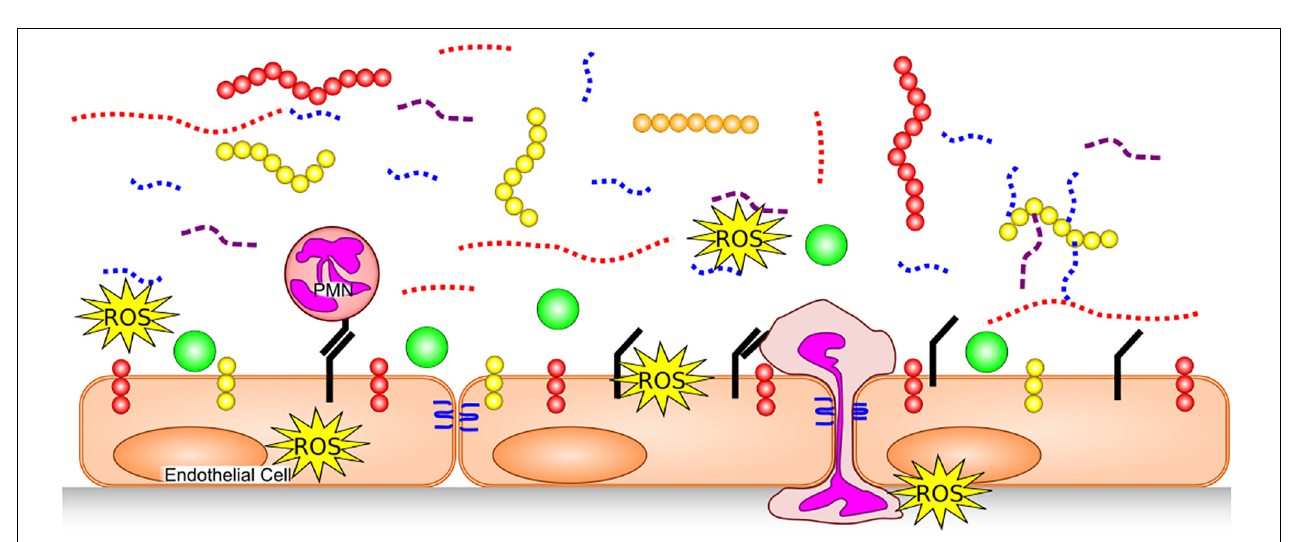
FIGURE 1 | Glycocalyx Structure. HA, dotted red lines, is bound to CD44 in membranes (red). HS (dotted blue) and CS (dashed purple) are covalently bound to syndecans (yellow) and glypican-1 (orange). Junctional proteins (blue), cellular adhesion molecules (black) adsorbed plasma proteins (green).